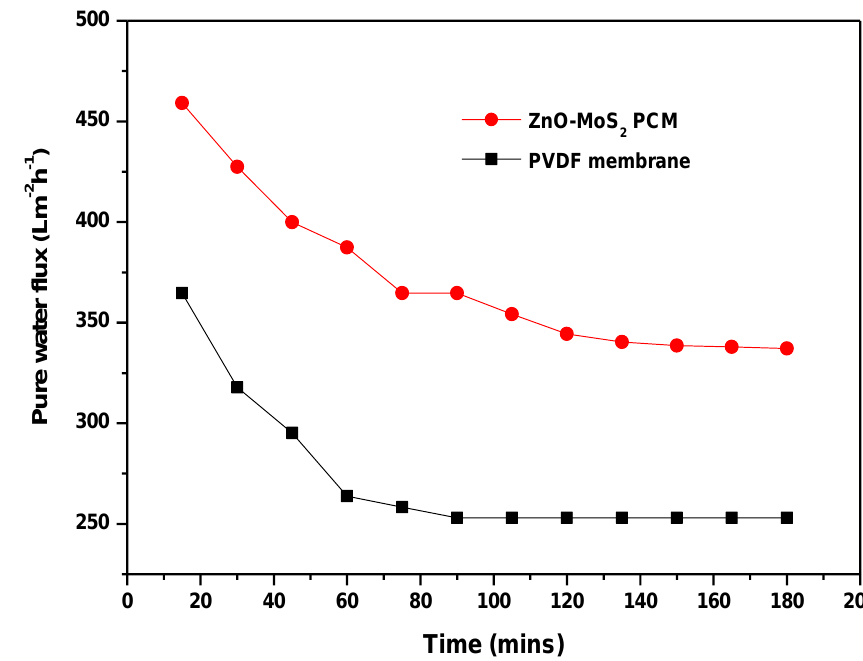
Figure 11. Pure water permeability of PVDF vs. the ZnO-MoS 2 PCM.